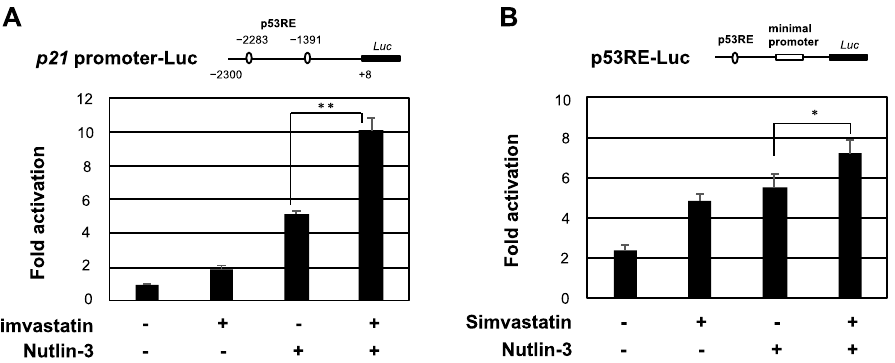
Figure 4. Simvastatin enhances the transcriptional activation of p53. ( A , B ) MCF7 cells were trans- fected with a construct combining the indicated reporter plasmid and pCMV/ β -gal. After 24 h, cells were treated with 10 µ M nutlin-3 in the presence or absence of 3 µ M simvastatin for 6 h. Luciferase activity in cell lysates was measured and normalized by β -gal activity. Experiments were performed in triplicate and data were expressed as the mean activation factor ± S.D. Significant differences are indicated as ** p < 0.01, * p < 0.05.